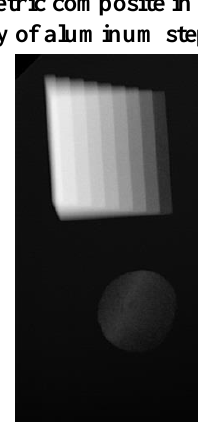
Figure 2: radiograph showing the